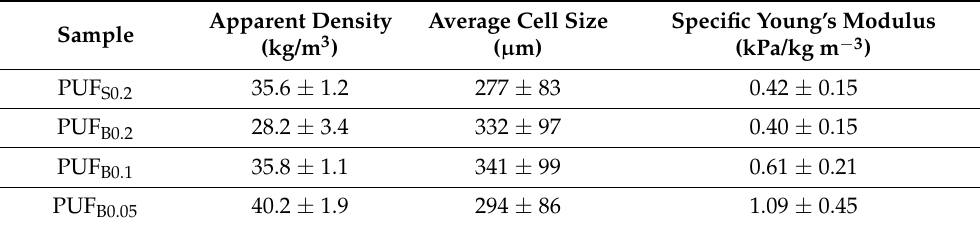
Table 2. Characteristics of the developed PUF: density, average cell size and specific Young’s Modulus.